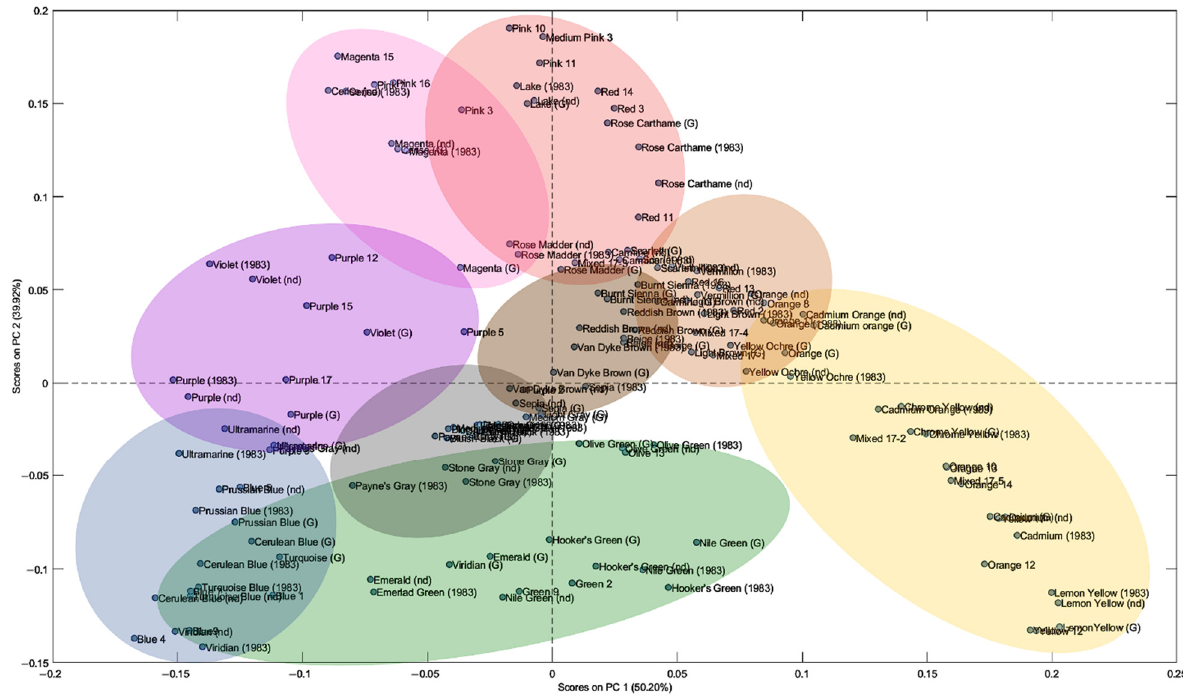
Figure 3 . Principal component analysis (PCA) was performed on a total of 156 averaged spectra to group the spectra and identify the watercolors used in the execution of this copy of Shoe Perdu . The colored ellipses do not represent confidence intervals and are used to better represent grouping based on hue. The GCI brochure is indicated by (G), the undated MoMA brochure is indicated by (nd), and the 1983 MoMA brochure is indicated by (1983). The spots from Shoe Perdu are indicated by their color and plate